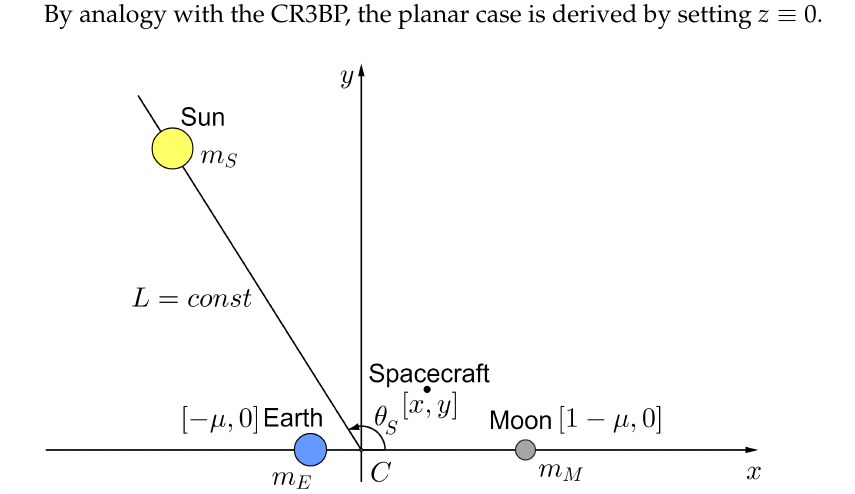
Figure 2. Rotating reference frame in the Earth–Moon–Sun bicircular restricted four-body problem. The figure is drawn for the planar case (the z -coordinate is dropped), though also valid in the 3D